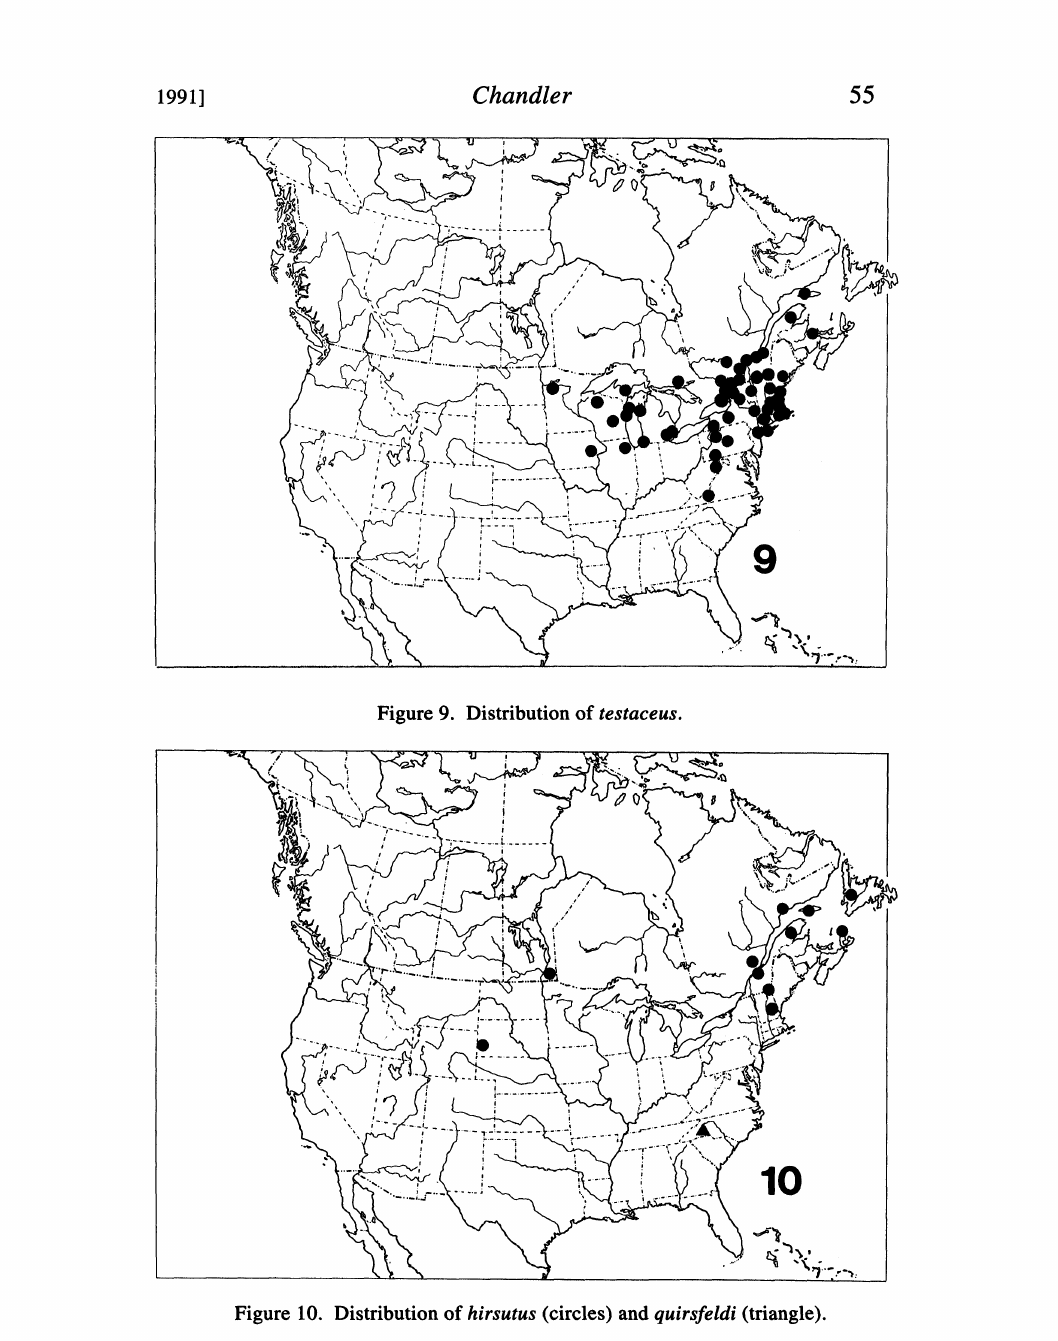
Figure 10. Distribution of hirsutus (circles) and quirsfeldi